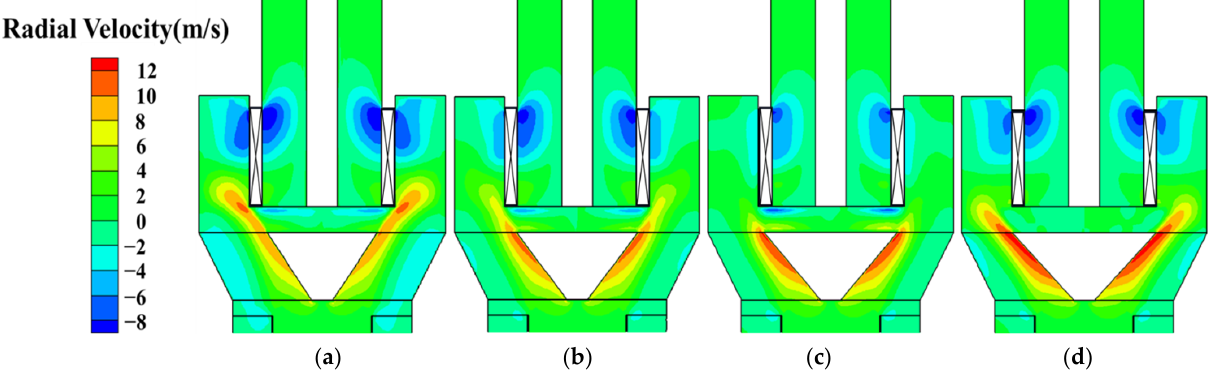
Figure 13. Effect of the guide cone diameter on the radial velocity: ( a ) D = 196 mm, ( b ) D = 216 mm, ( c ) D = 236 mm, ( d ) D = 256 mm.